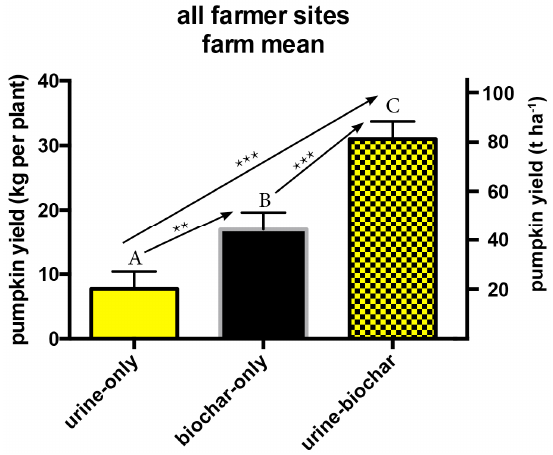
Figure 2. Mean pumpkin yield of all farmer sites. Notes: Mean pumpkin yield of all farmer sites in kg per plant and t·ha − 1 . The statistic analysis was calculated with the linear mixed effects models (lmer), including the site-specific random effects of the eight sites. Codes of significance are *** for p < 0.001 and ** for p < 0.01. The yield in t·ha − 1 was calculated with a plant density of 2630 plants·ha − 1 .